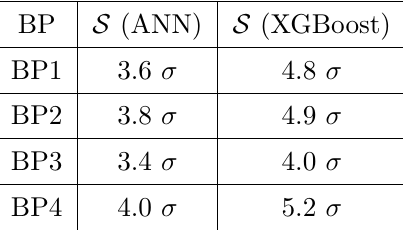
Table 9 . Signal signi(cid:12)cance for the benchmark points at 14 TeV with L = 3000 fb (cid:0) 1 for case II with ANN and